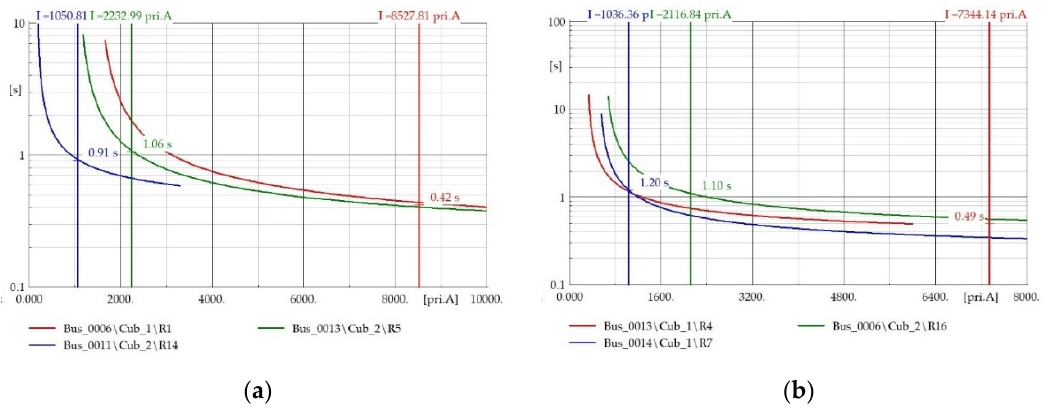
Figure 7. ( a ) T2, R1 (red) primary operation with backup R5 (green) and R14 (blue) obtained with cluster 1 settings; ( b ) T9, R4 (red) primary operation with backup R16 (green) and R7 (blue) obtained with cluster 1 settings.